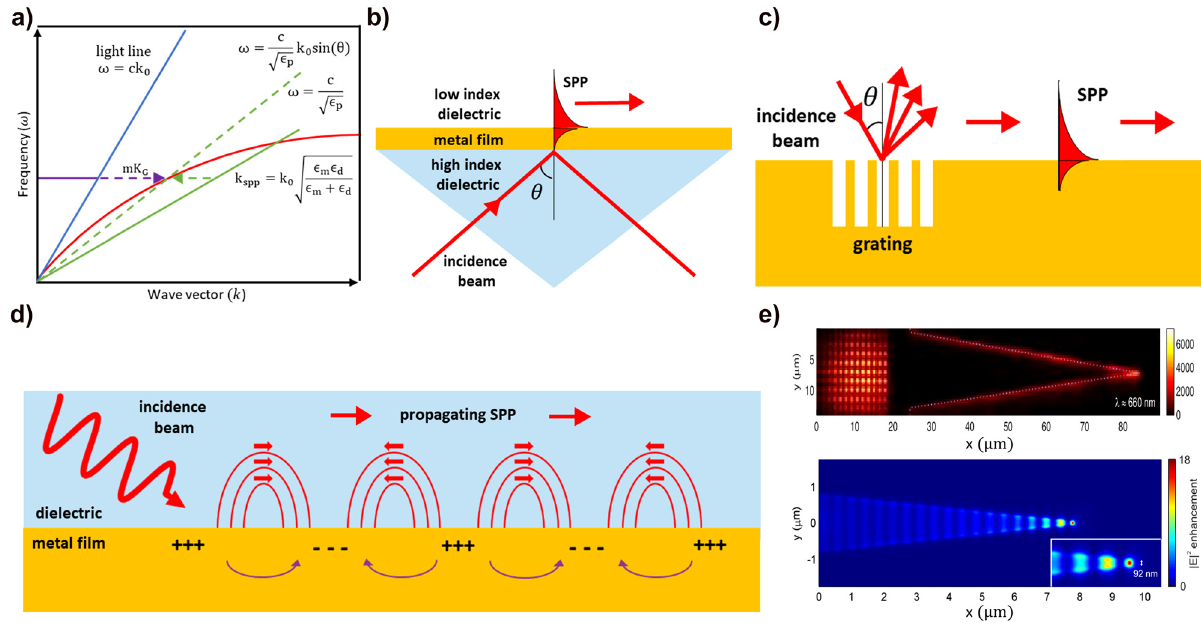
Figure 1: SPP excitation method and application. (a) Dispersion curve of the SPP and wave vector of the incidence beam at the dielectric/metal interface. SPP excitation method. (b) Kretschmann configuration, (c) grating coupling geometry. (d) Schematic of SPP propagating at the interface between the dielectric and the metal. (e) Nanoscale focusing of SPP by propagating through tapered structures. Upconversion luminescence image of SPP fi elds at the tapered plasmonic structure (upper panel), numerical simulation of focused SPP at V-groove structure (lower panel) Adapted with permission from ref. [49]. Copyright 2008, OSA.